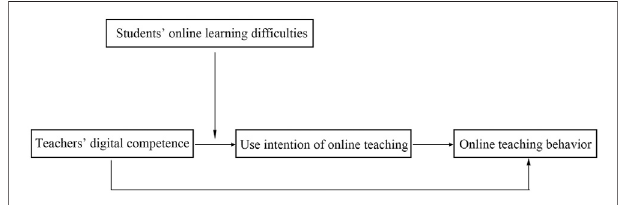
FIGURE 1 | Illustration of Conceptual